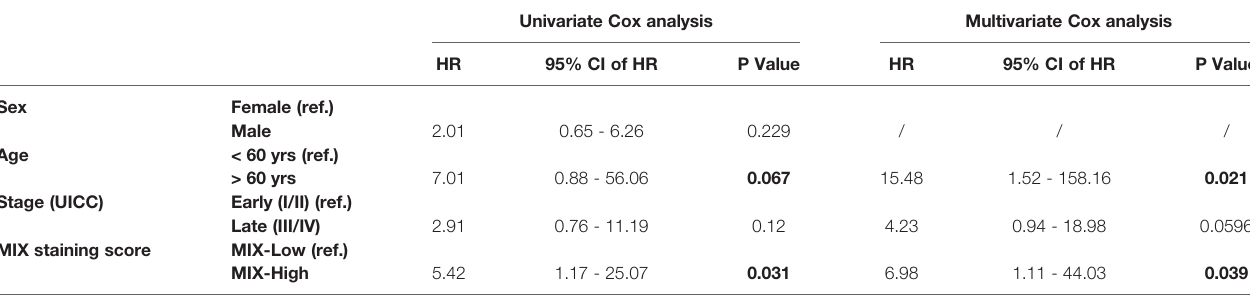
TABLE 4 | Prognostic values of clinicopathological features (sex, age, stage and MIX staining) at 5 years of patients ’ follow-ups (60 months) of chemotherapeutic- treated patients ’ cohort. Univariate Cox